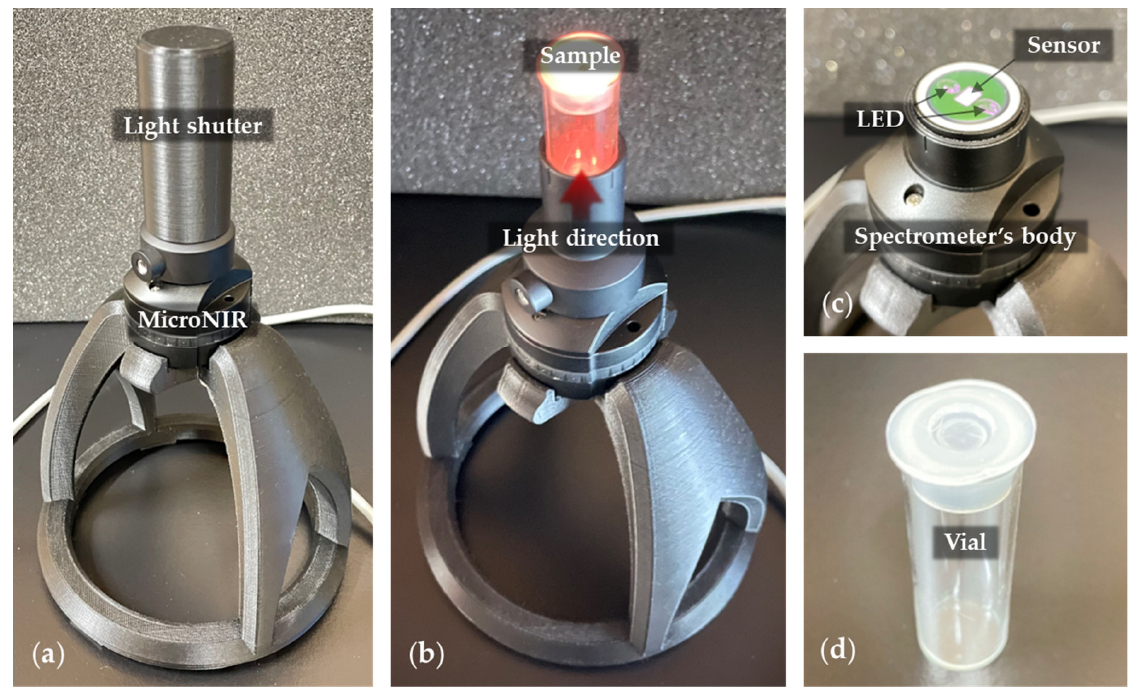
Figure 8. Near-infrared spectroscopy setup: ( a ) MicroNIR 1700-ES mounted on a 3D-printed stand and with a 3D-printed light shutter cap; ( b ) setup without light shutter, showing the sample’s position and measurement; ( c ) MicroNIR 1700-ES device; ( d ) empty glass vial as a sample container, with 2 replicates per water at specific frequency, in a total of 40 spectra acquired (2 waters at 2 frequencies with 2 replicates, each measured 5 consecutive times).